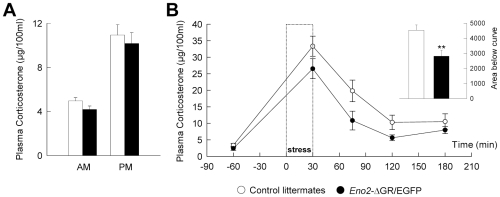
Basal and stress-induced corticosterone secretion in Eno2-ΔGR/EGFP bigenic mice.(A) Plasma corticosterone concentrations were determined in basal conditions from blood collected either one hour after light on (AM = 8 am) or one hour after light off (PM = 8 pm), these two time points correspond respectively to the lowest and highest levels of corticosterone during circadian secretion. Control (n = 15) and Eno2-ΔGR/EGFP bigenic mice (n = 10). (B) Kinetics of glucocorticoid secretion in response to stress (30 minutes of forced exposure to an open field). Mice were bled several times related to each time point and blood samples were collected from control (n = 13) and Eno2-ΔGR/EGFP bigenic mice (n = 10) 60 minutes before the beginning of the stress (t-60), at the end of the stress (t30), then 75, 120 and 180 minutes after the beginning of the stress. Insert represents the area under the curve; ** = P<0.01. Plotted values are means +/− sem.